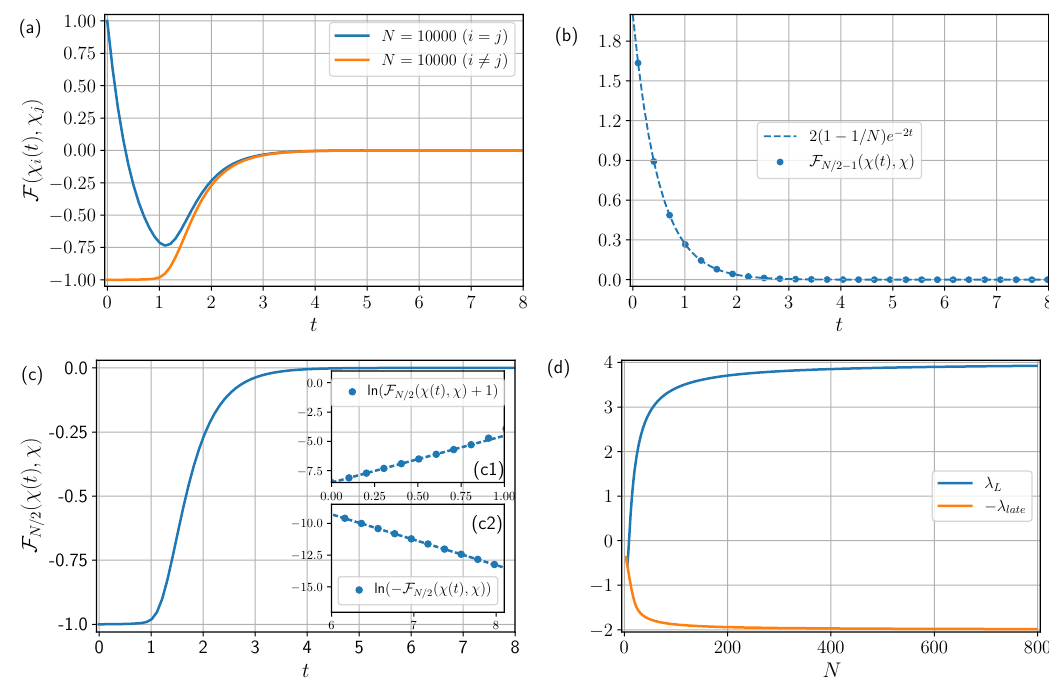
Figure 3 . (a) The OTOC F ( χ i ( t ) , χ j ) for i = j and i 6 = j , computed according to eq. (4.22), for N = 10000 fermions. (b) The contribution to the OTOC from the irrep L = N/ 2 − 1 exponentially decays with time. The curve is fitted against e − 2 t . (c) The contribution to the OTOC from the irrep L = N/ 2 , vs time for N = 10000 fermions, displaying scrambling behavior. The insets (c1) and (c2) show exponential Lyapunov growth in the early time regime and exponential decay in the late time regime, fitted against the lines 4 t − ln ( N ) and − 2 t + ln (15) respectively. Thus the curve follows the ansatz in eq. (4.26). (d) The plot of λ and − λ as a function of N . L late